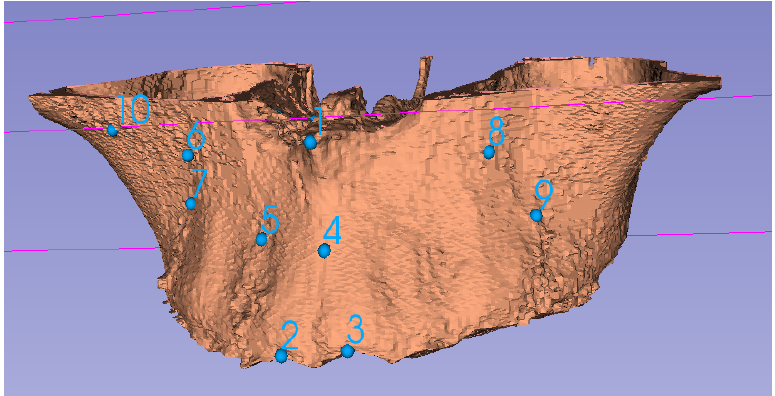
Figure 2. Segmentation of the midface with special attention on the maxilla and contiguous parts of the palatine bone, showing some homologous landmarks (1–10).